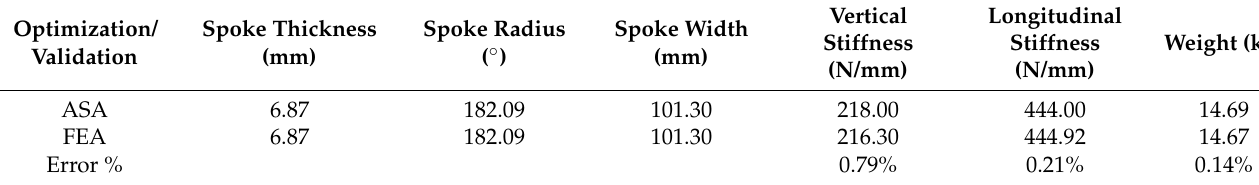
Table 5. Optimization results achieved using three algorithms.